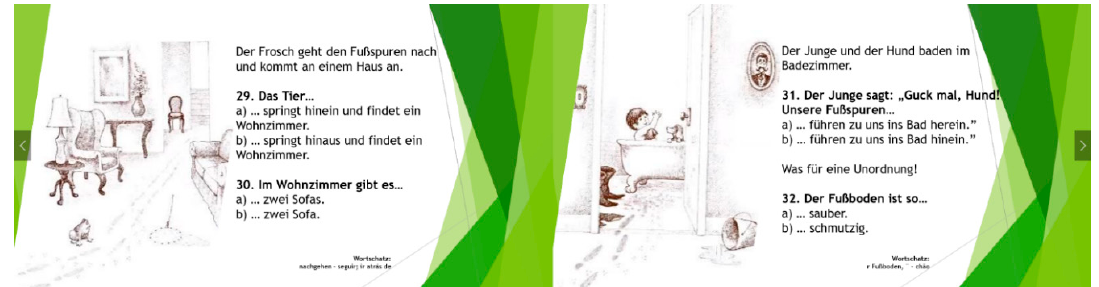
Figure A24. Pretest: Binary-choice recognition task.